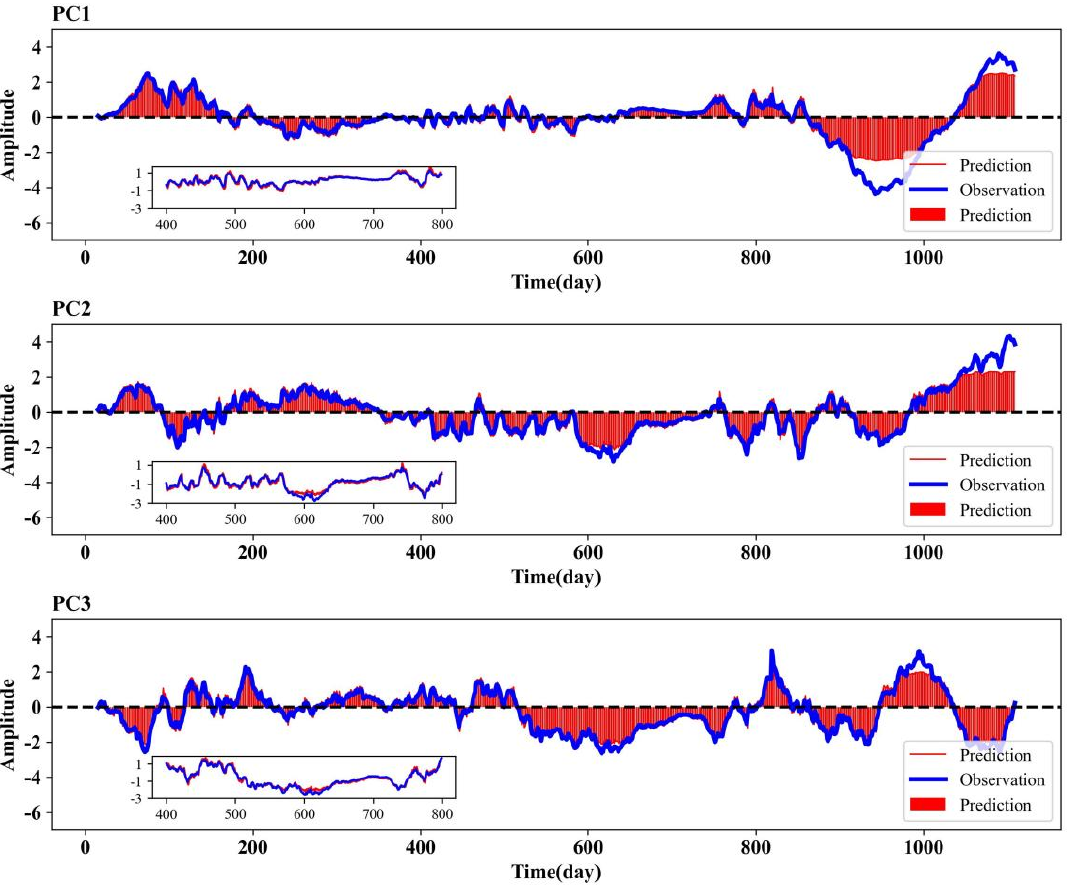
Figure 5. Forecast trend (100th minus first) of PC1 to PC3 by EOF–LSTM–DNN model (red line) compared with the corresponding truth (blue line), also a partial magnified view of the comparison results between the 400th and 800th days.